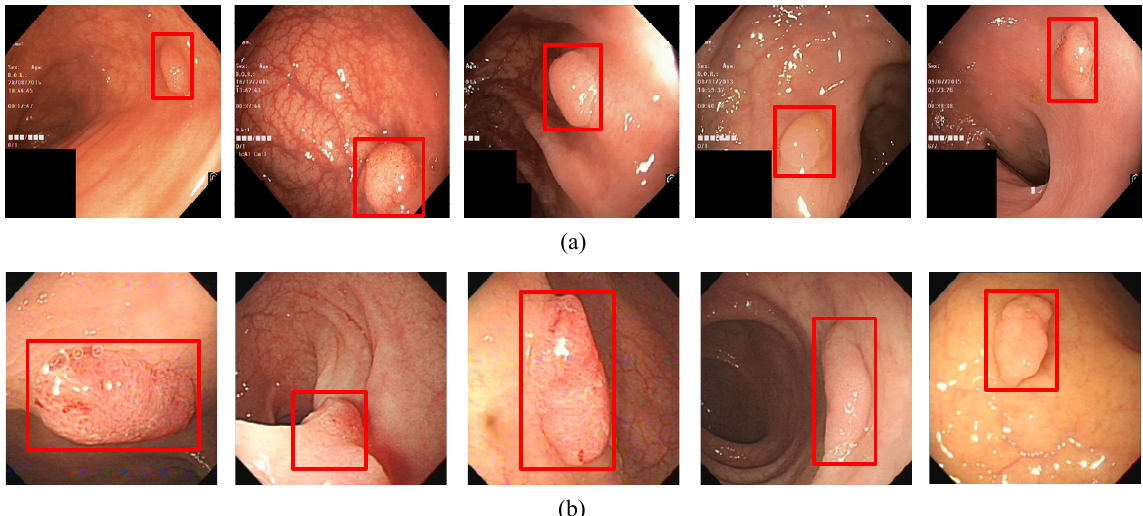
Figure 8. ( a ) A subset of the detection results of multiple target polyps showing low contrasts to the background in Kvasir-SEG data set. ( b ) A subset of the detection results of multiple target polyps showing low contrasts to the background in WCY data set. The red squares in the figure are the bounding boxes of the polyps.